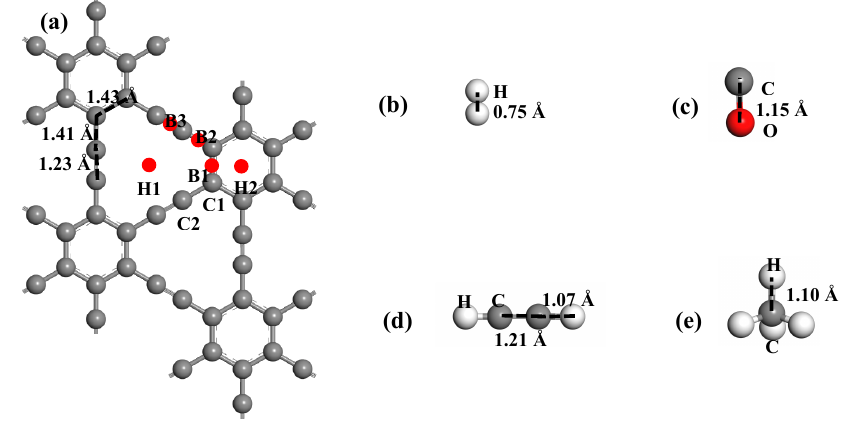
Figure 1. Geometric structures of: ( a ) pristine graphyne with different adsorption sites; ( b ) H 2 ; ( c ) CO; ( d ) C 2 H 2 ; ( e ) CH 4 . Table 1. Binding energy and electron transfer of one Pd atom onto a graphyne monolayer. Adsorption